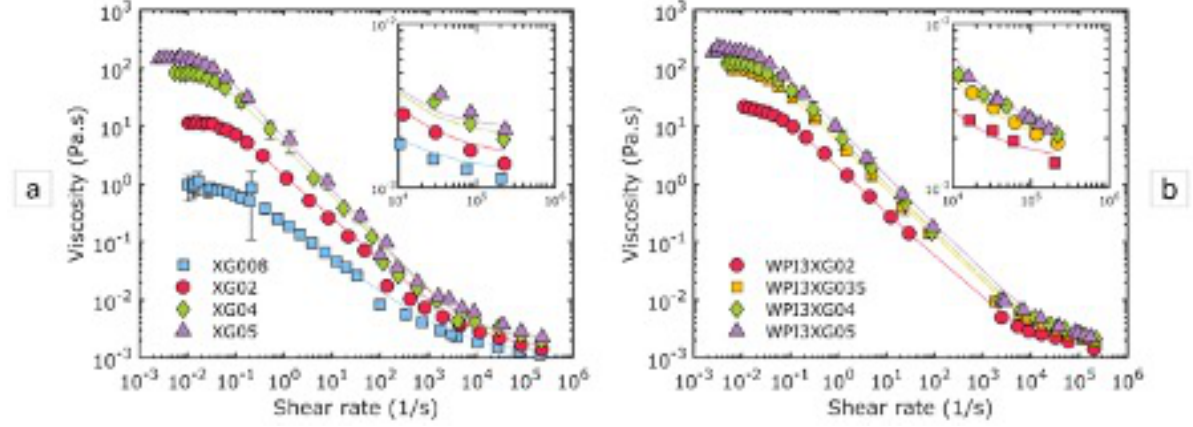
Figure 7: Experimental data and model fits (solid lines) built from the correlations as a function of concentration. a) XG solutions. b) WPIXG